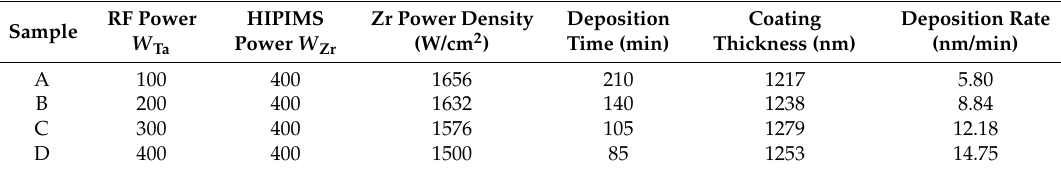
Figure 1. Schematic image of the radio-frequency magnetron sputtering and high-power impulse magnetron sputtering (HIPIMS/RFMS) co-sputtering equipment. Table 1. Sputter parameters for depositing Ta–Zr–N thin films.